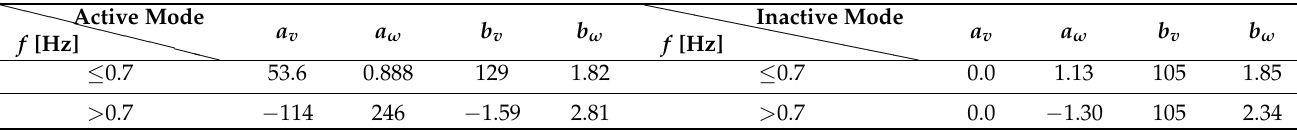
Table 2. Each parameter list of Equation (1). The left side is the parameter for active search, and the right side is the parameter for inactive